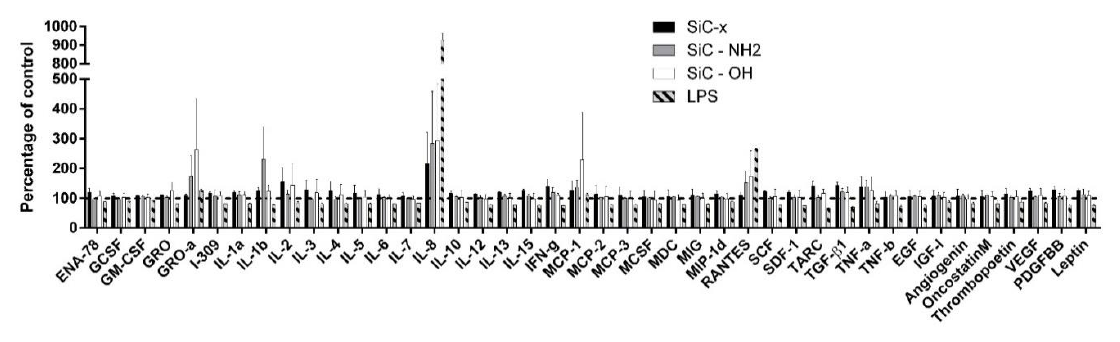
Figure 5. Cytokines detected in the supernatant from the suspension THP-1 monocytes. Cells were treated with 100 µ g / mL of SiC-based NPs or LPS under non-standard conditions. After 24 h of incubation, cell supernatant was harvested and analyzed for the presence of a broad panel of cytokines. The data was normalized and is presented as a percentage of the untreated control supernatant levels. The error bars show standard deviation. The dashed line shows 100% of the untreated control.